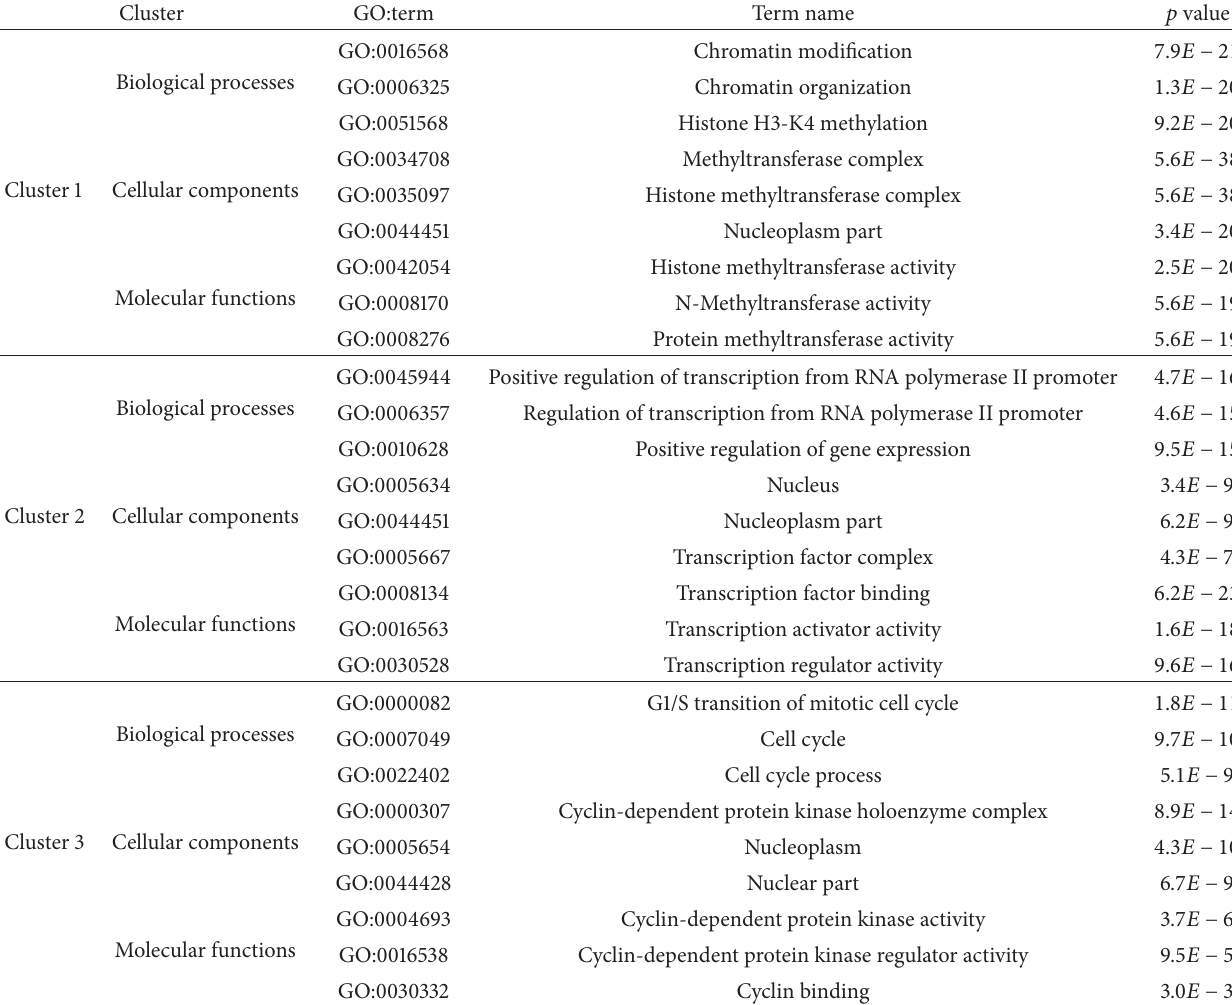
Table 1: The functional characterization of protein interaction networks in three